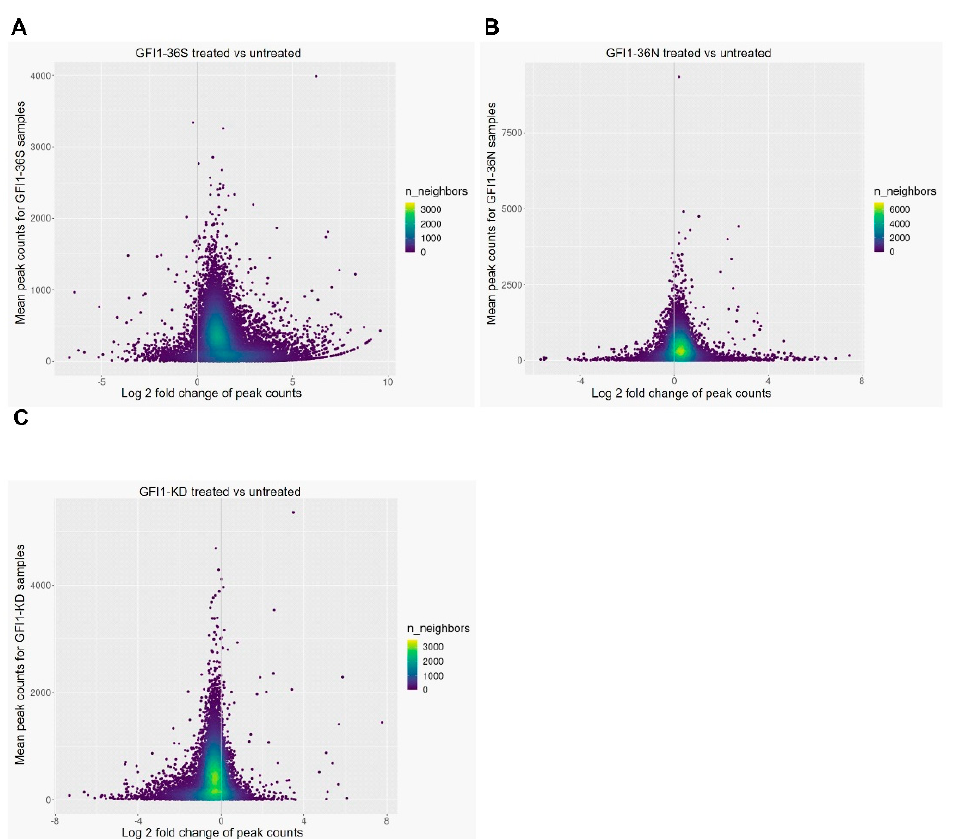
Figure 3. Curcumin treatment affected GFI1 promoter occupancy in the c-kit+ cells GFI1-36S/-36N and -KD, NUP98/HOXD13-tg mice. CHIP sequencing was performed in the frozen BM cells of GFI1-36S/ -36N and -KD, NUP98/HOXD13-tg mice. The mean and log2 fold change of peak counts (promoter ± 1 kb) in GFI1-36S ( A ), -36N ( B ) and –KD ( C ), NUP98/HOXD13-tg mice (vehicle vs curcumin treatment) are shown. Peak counts were calculated as normalized read counts for each consensus peak located in promoter regions (±1 kb). Individual points are coloured by the number of neighbouring points to display the point density.